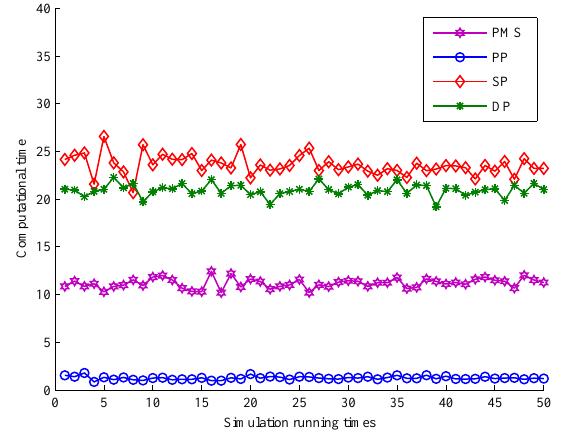
Figure 7. The comparison of four approaches in computation time